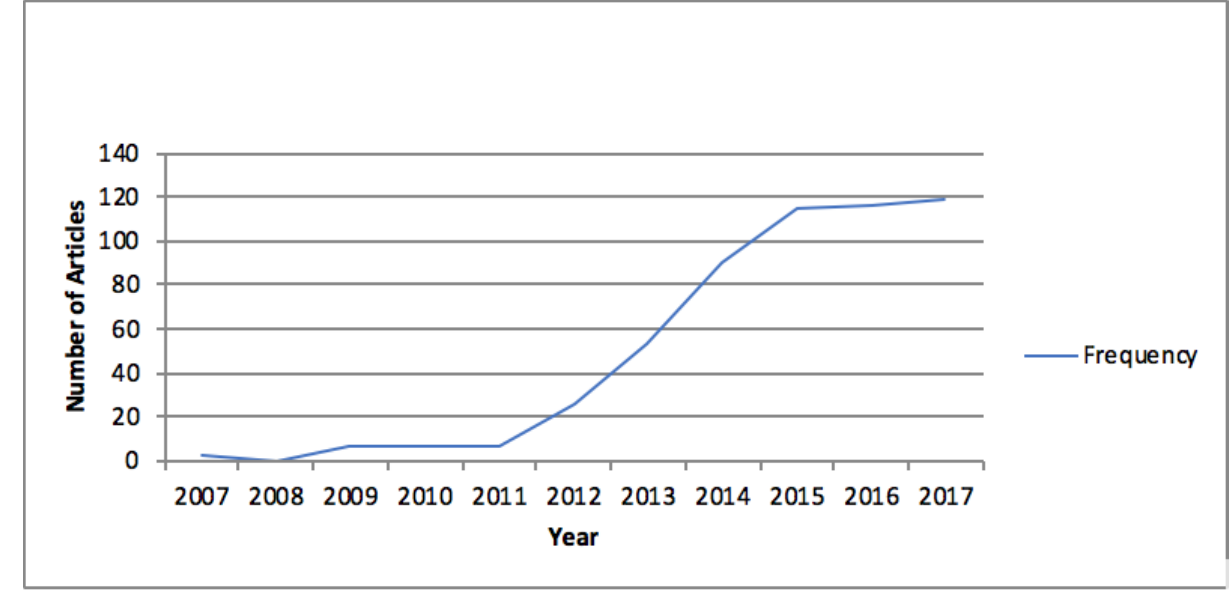
Figure 3. Frequency of articles published by year